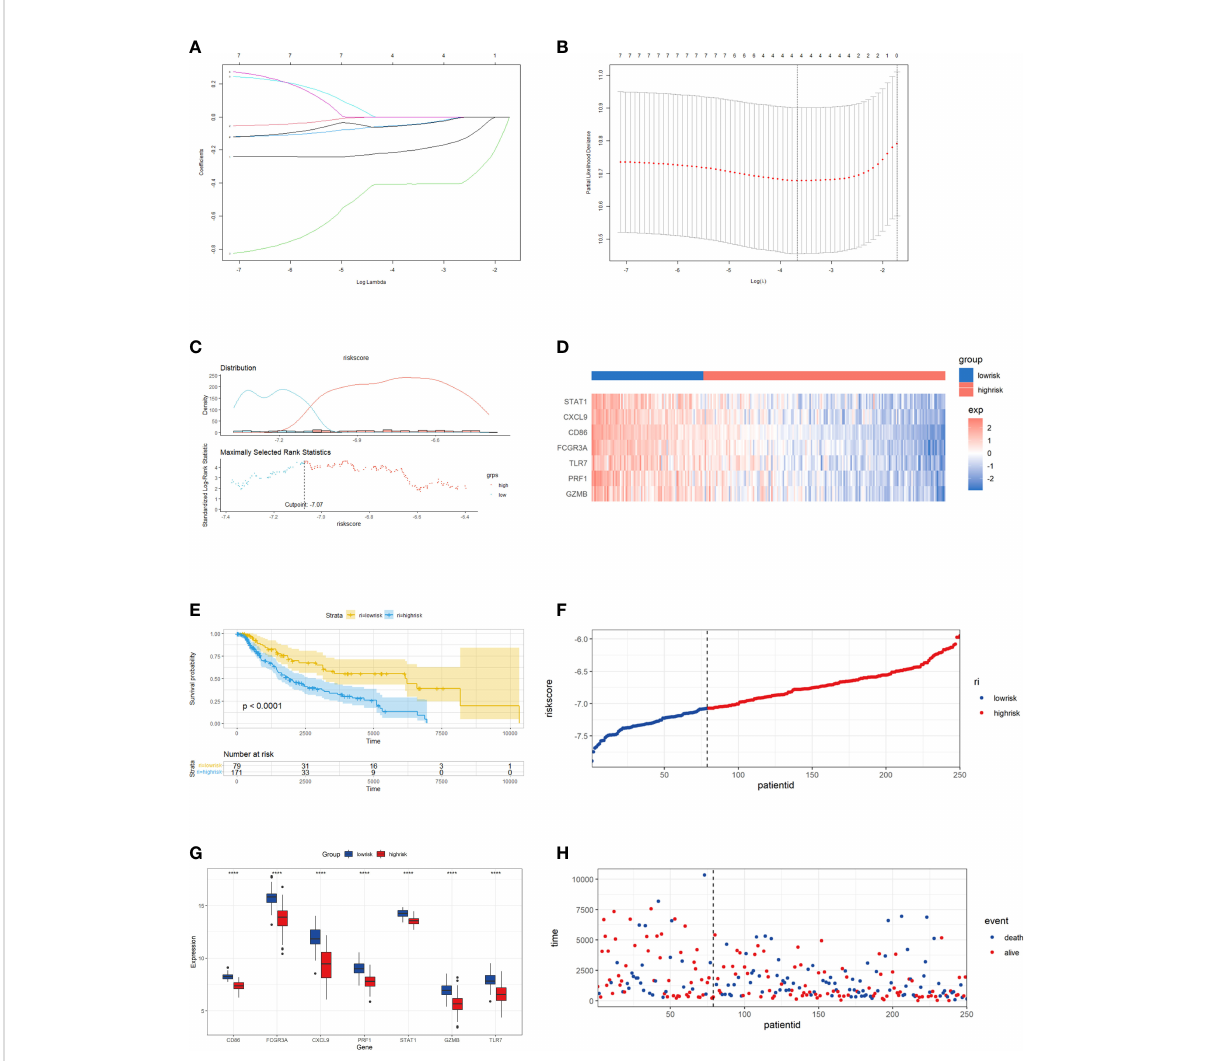
FIGURE 6 Construction of riskScore signature in cutaneous melanoma. (A) Least absolute shrinkage and selection operator (LASSO) coef fi cient pro fi les of the seven key molecules. Horizontal axis represents log of independent variable l . Vertical axis represents coef fi cient of independent variable. (B) Tenfold cross-validation of tuning parameters in LASSO model. (C) The optimal cut-off point to dichotomize riskScore into low and high groups was determined by MaxStat R package. The optimal cutoff point was -7.07. (D) Survival analyses for low (79 samples) and high (171 samples) riskScore groups using Kaplan-Meier curves. (E) The seven key molecules expressed in the low and high risk groups (**** P < 0.0001). The results showed that a strongly signi fi cant difference was exhibited between the groups. (F) The median value and distribution of the risk score. (G) The distribution of overall survival (OS) status. (H) Hierarchical clustering of seven key genes between low and high risk groups. Red represents up-regulated and blue represents